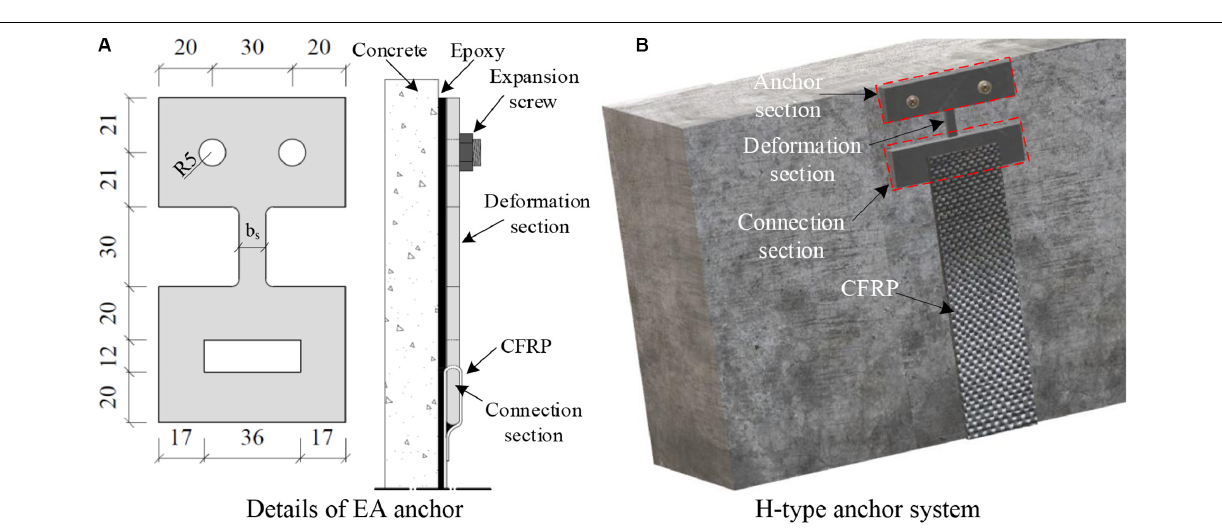
FIGURE 4 | Details of H-type EA-FRP strengthening system (units: mm). (A) Details of EA anchor. (B) H-type anchor